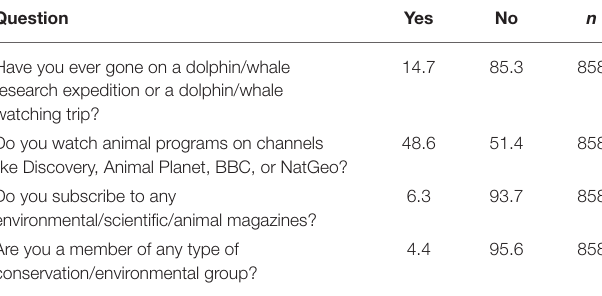
TABLE 10 | Responses to four questions pertaining to participant’s environmental related